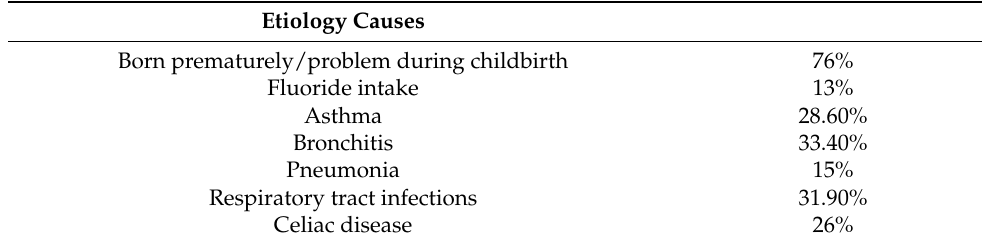
Table 1. Pre-treatment questionnaires on etiological causes.